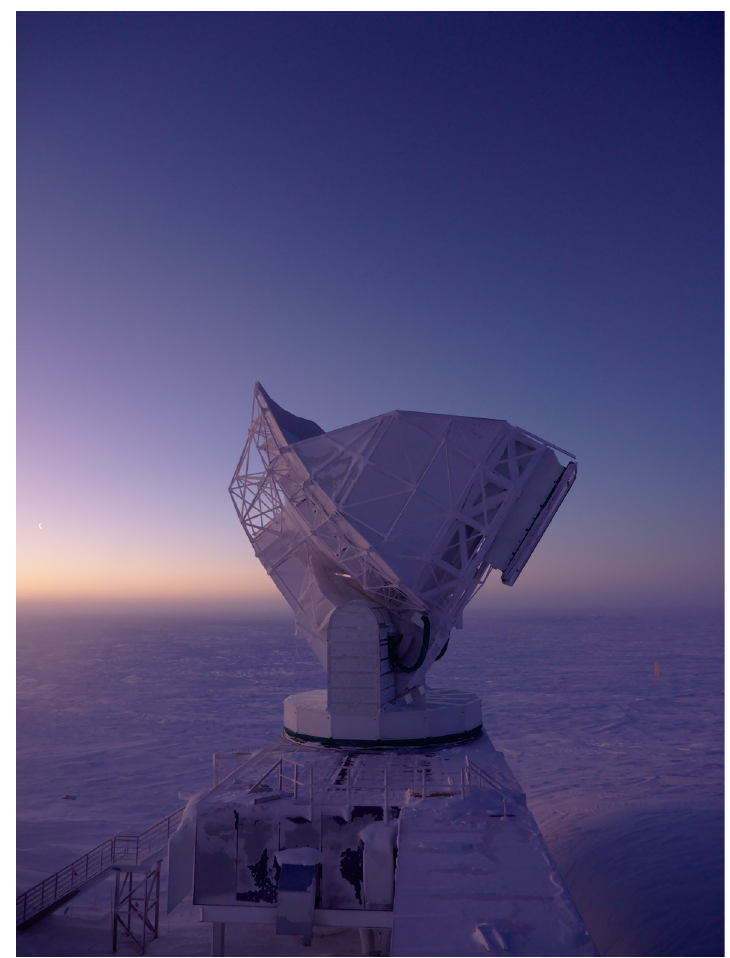
Figure 1. South Pole Telescope. Credit: NSF /